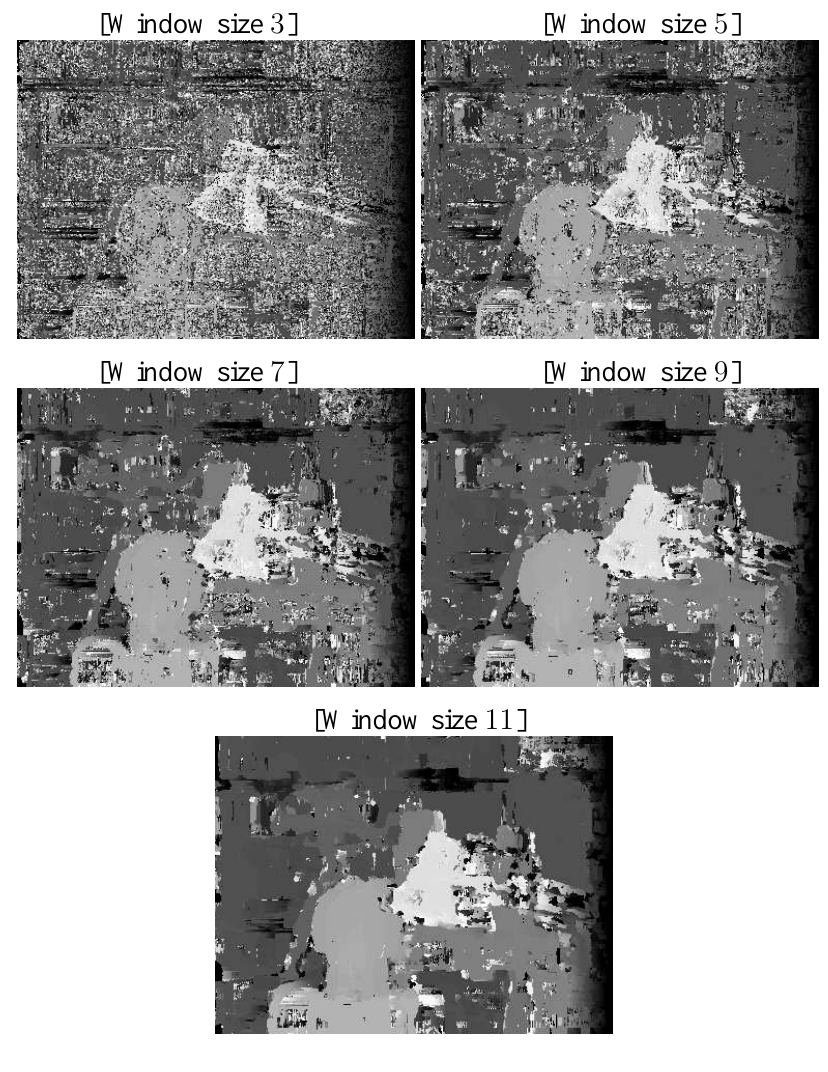
Figure 20. Disparity maps, Kumar and Chatterji algorithm, for window of sizes 3 , 5 , 7 , 9 , and 11 (from top to